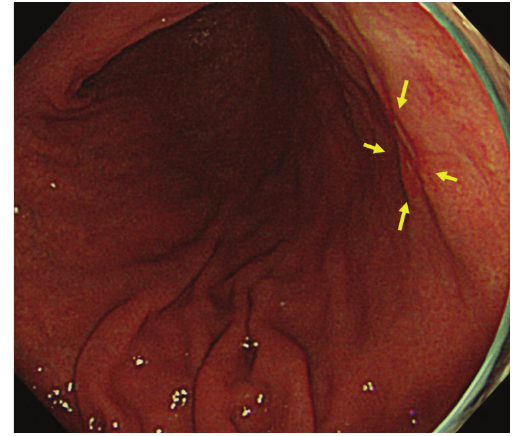
Figure 5: Endoscopic image of a patient in group R showing a depressed lesion on the posterior wall of the lower gastric body (yellow arrow).